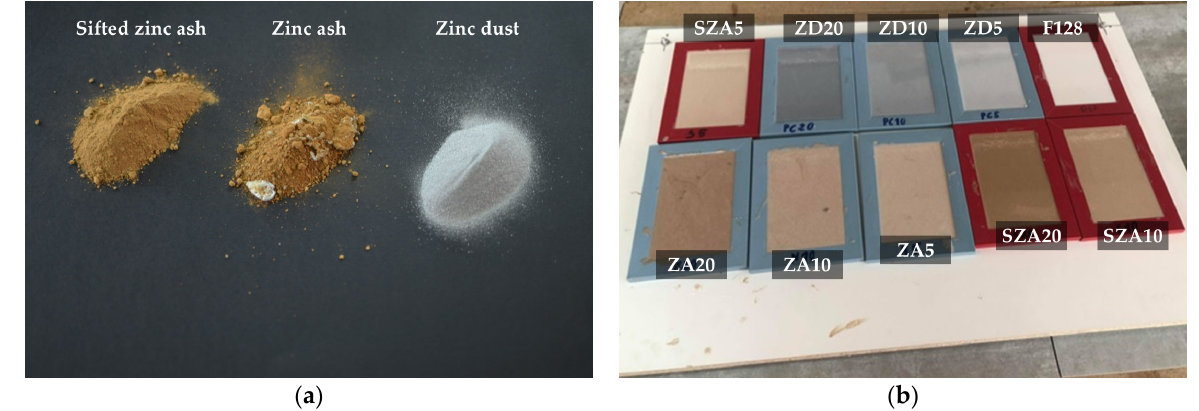
Figure A1. Materials used in the research: ( a ) fillers; ( b ) silicon composites cast into wooden molds.